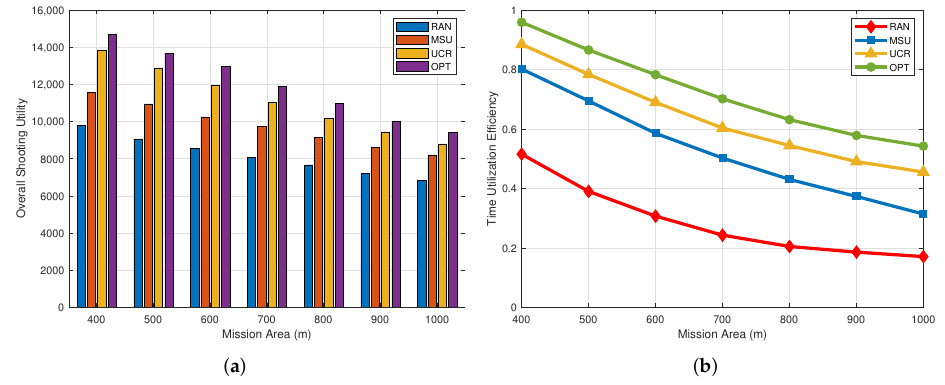
Figure 6. Impact of the target distribution density. ( a ) Overall shooting utility; ( b ) Time utilization efficiency.